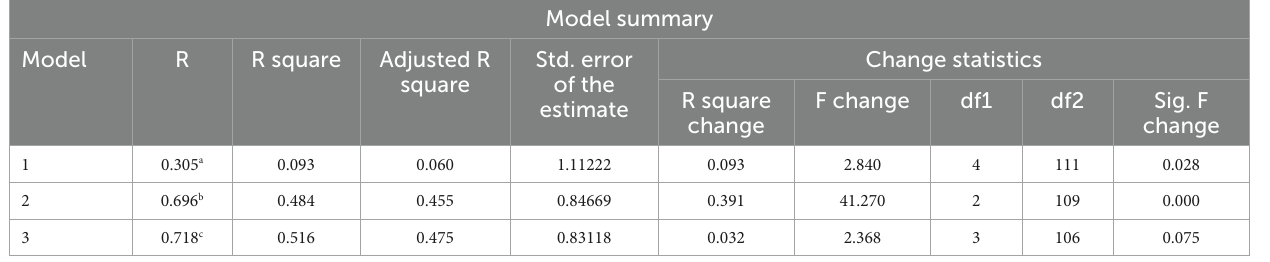
TABLE 4 Predictors of job burnout, model